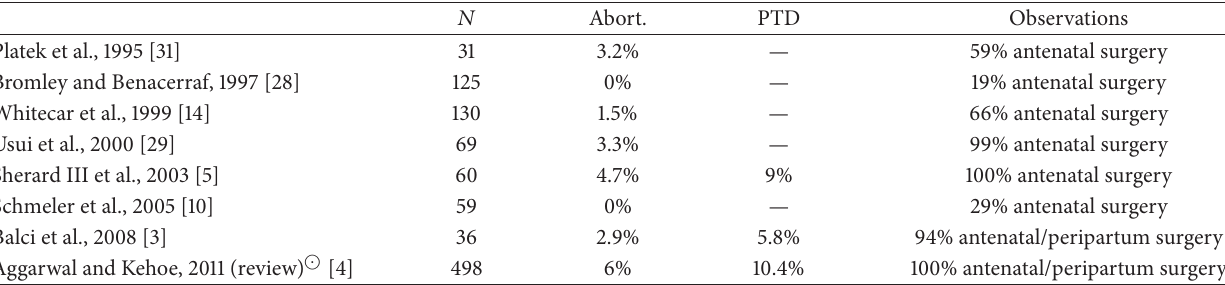
Table 7: Obstetric impact of adnexal masses in